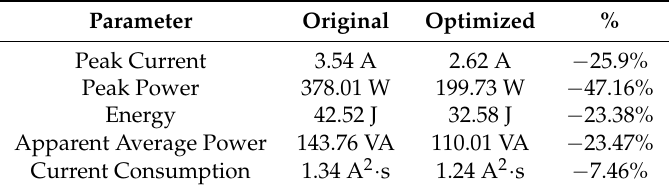
Table 4. Simulation with load. Final velocity: 50 rads/s. Final time: 0.5